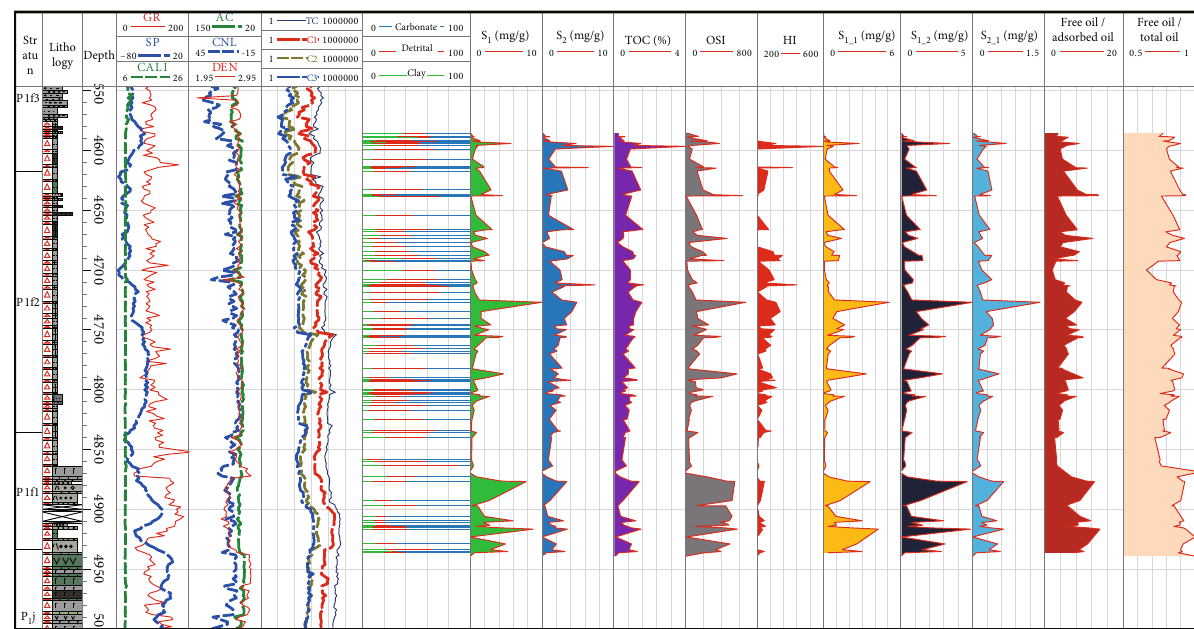
Figure 10: Oil-bearing property of the Fengcheng Formation shale and shale oil mobility characteristics in the Mahu